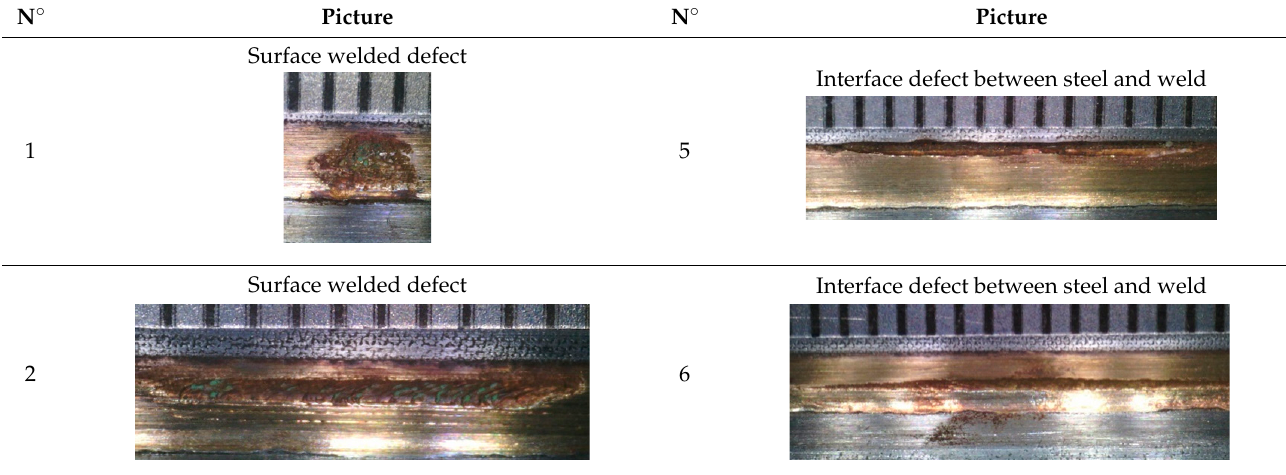
Table 1. Artificial defects produced in the sample to be inspected (scale in mm). N°